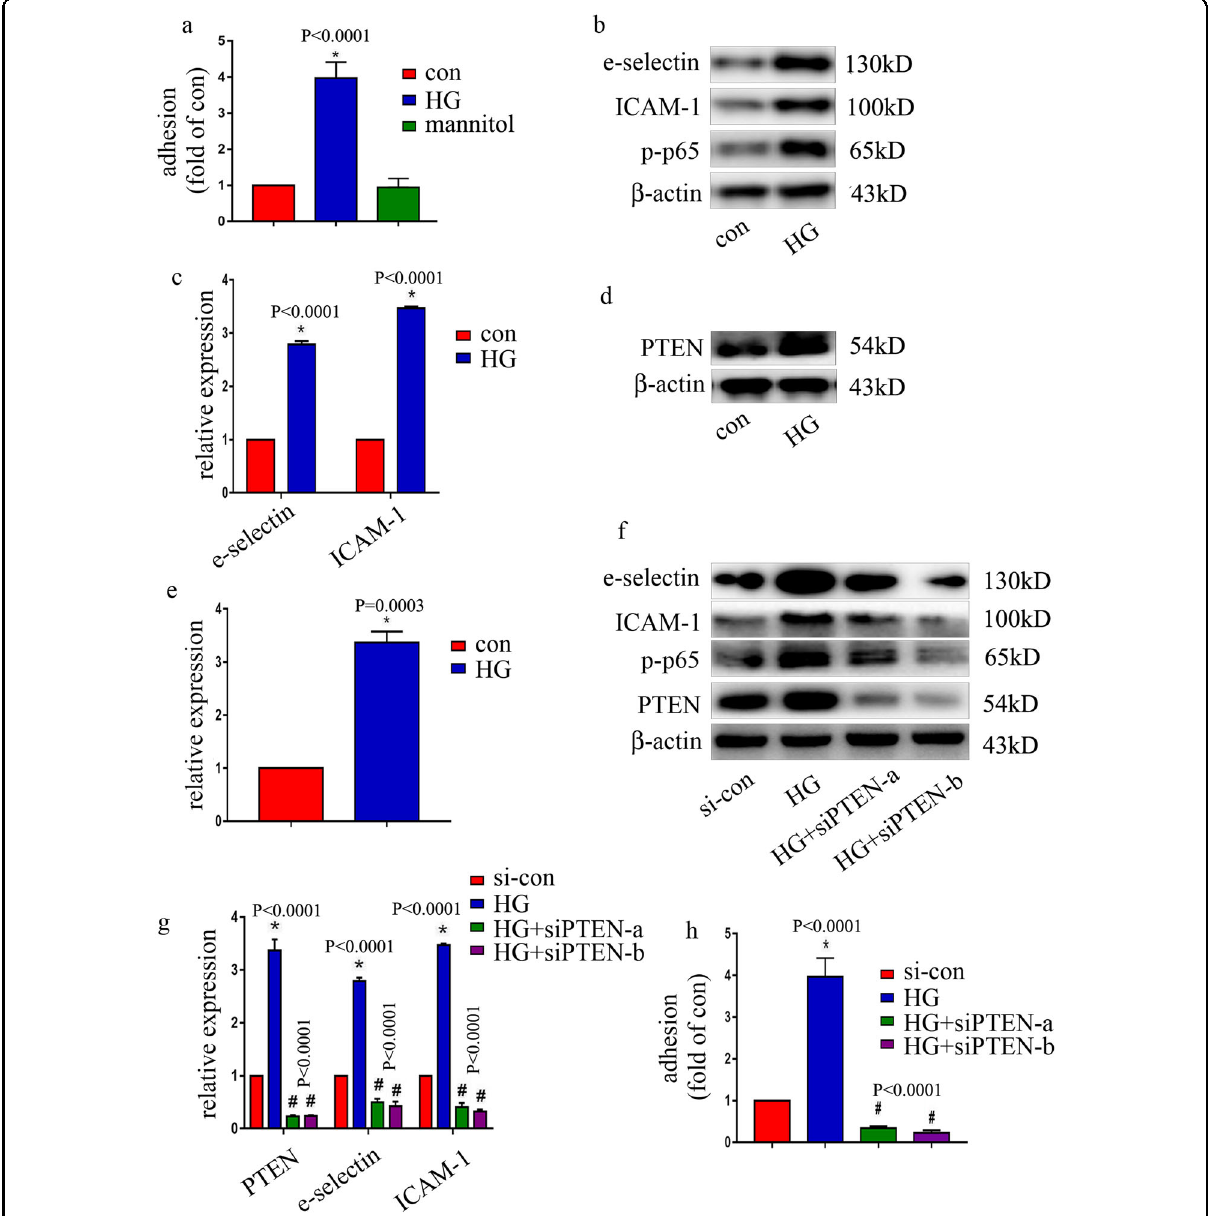
Fig. 2 High glucose mediated endothelial in fl ammation via the upregulation of PTEN expression in HUVECs. a Monocyte/endothelial adhesion under normal, high-glucose or osmotic control conditions was measured. b Results from the western blot analysis of e-selectin, ICAM-1, and p-p65 expression in HUVECs cultured under normal or high-glucose conditions. c mRNA expression of e-selectin and ICAM-1 was examined by qPCR in cells grown in normal or high-glucose medium. d Results from the western blot analysis of PTEN expression in HUVECs cultured under normal or high-glucose conditions. e mRNA expression of PTEN was measured by qPCR in cells grown in normal or high-glucose medium. f The effects of siPTEN on high glucose-induced e-selectin and ICAM-1 expressions, and p65 phosphorylation in HUVECs were assessed by western blot analysis. g The effects of siPTEN on high glucose-induced e-selectin and ICAM-1 expressions in HUVECs were assessed by qPCR analysis. h The effects of siPTEN on high glucose-induced monocyte/endothelial adhesion were measured. * P < 0.05, compared with the control group; # P < 0.05, compared with the high-glucose treatment group, n =